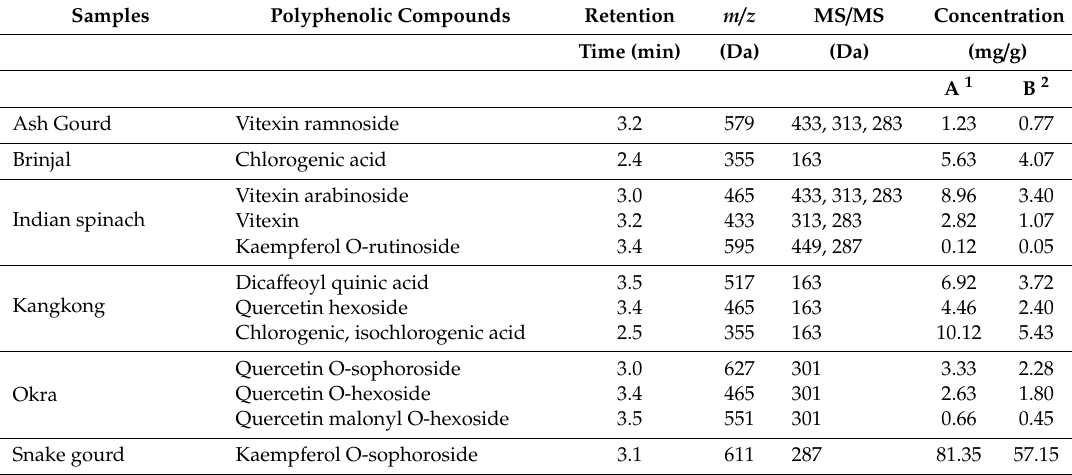
Table 1. Main polyphenolic compounds of aqueous extracts of vegetables